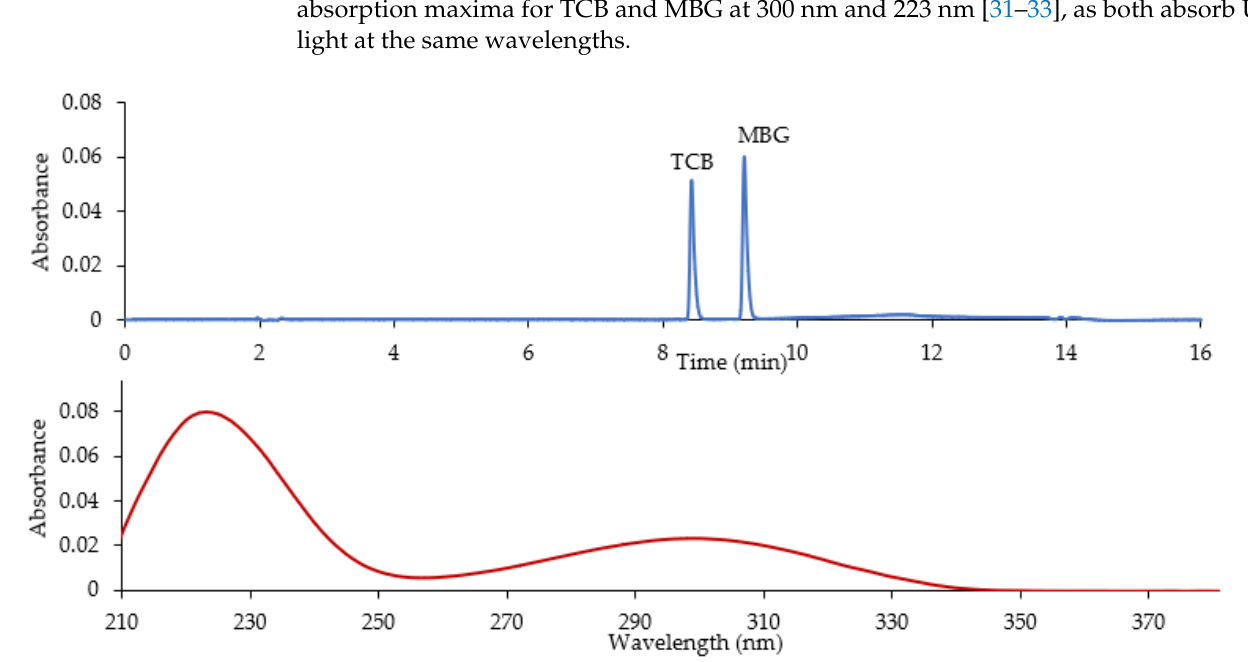
Figure 2. HPLC-PDA profile of CTS dissolved in mobile phase; retention time for TCB and MBG based on UV light absorbance at 300 nm (top figure), UV spectrum showing the absorption maxima for TCB at 223 and 300 nm (bottom figure). MBG shows similar absorption spectrum as TCB.